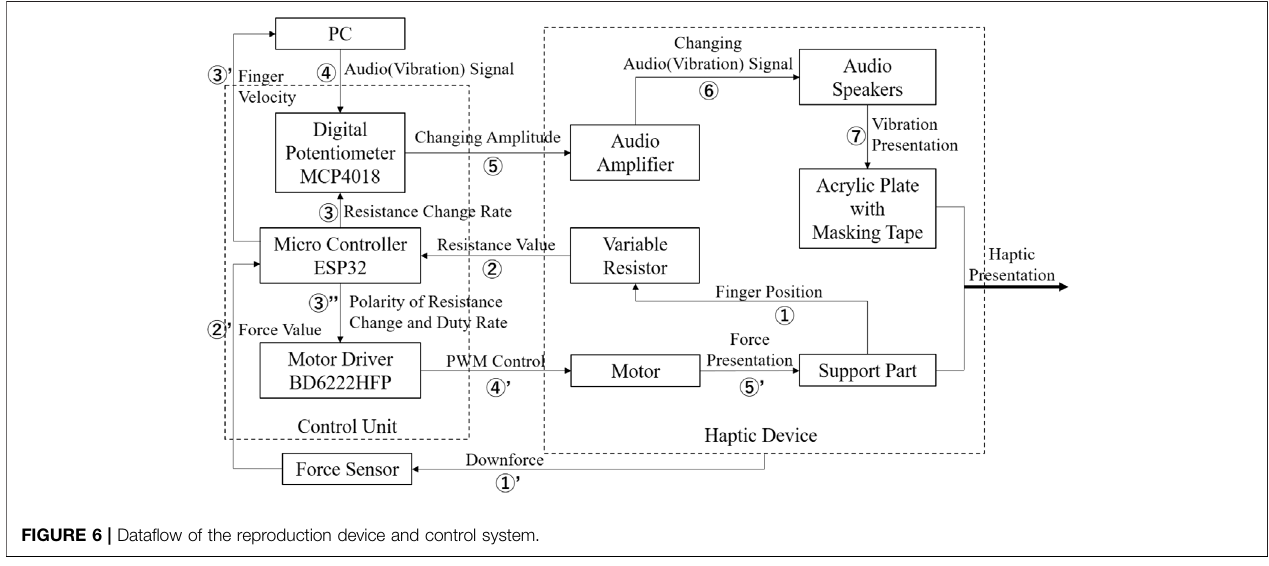
FIGURE 6 | Data fl ow of the reproduction device and control system.